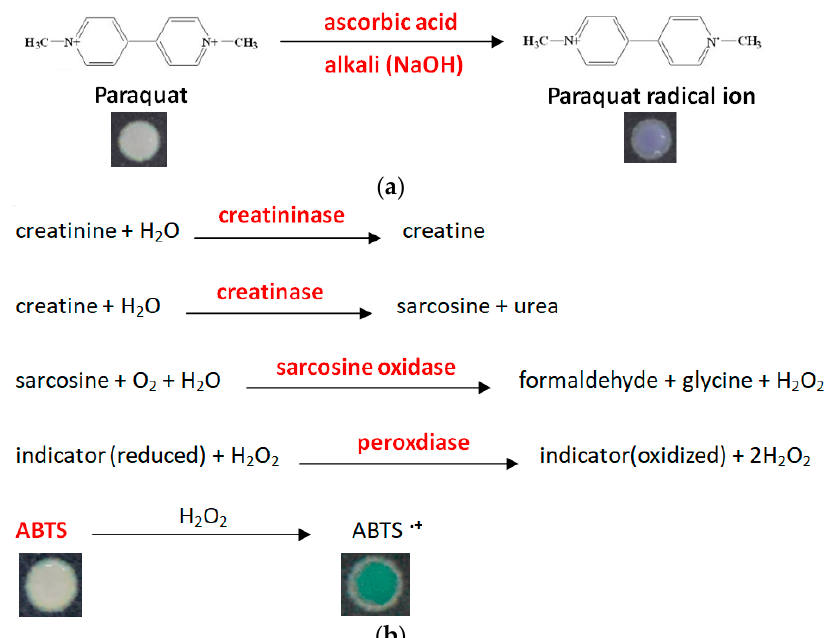
Figure 2. Mechanism of paraquat and creatinine assay: ( a ) paraquat mechanism in our paper-based analytical device, ( b ) creatinine mechanism in our paper-based analytical device (red text indicates the agent being added to our paper-based analytical device).